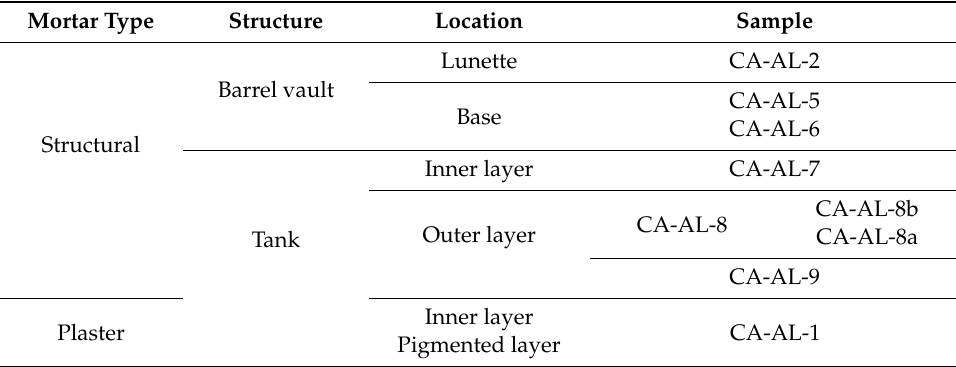
Table 1. Lime mortar samples from the di ff erent locations in Amaiur Castle